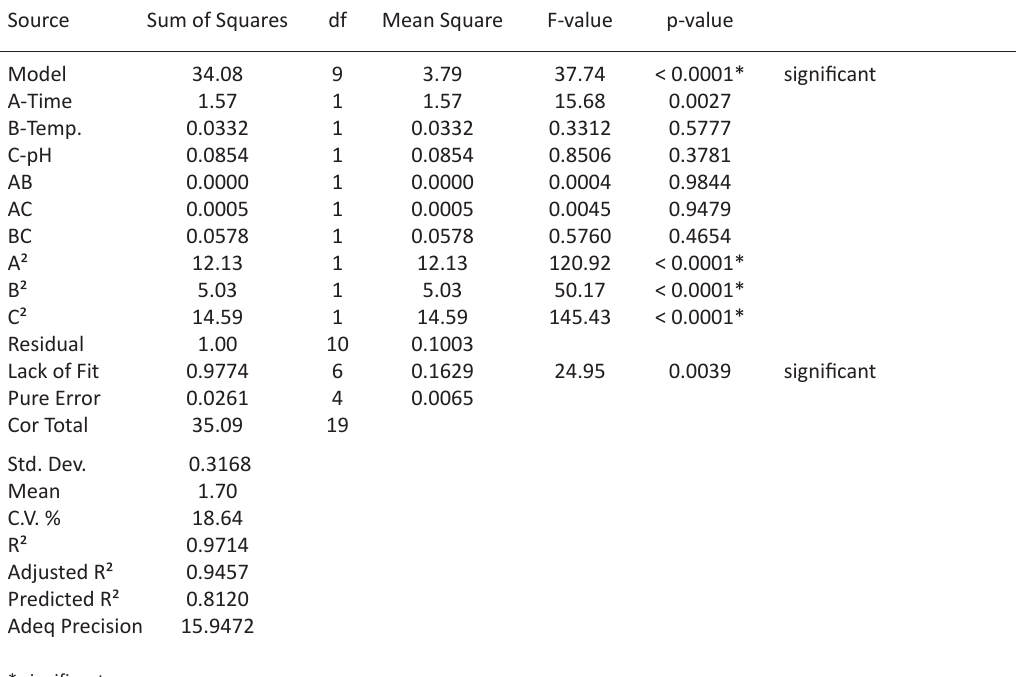
Table 2. Analysis of variance (ANOVA) for laccase production in second-order polynomial model Source Sum of Squares